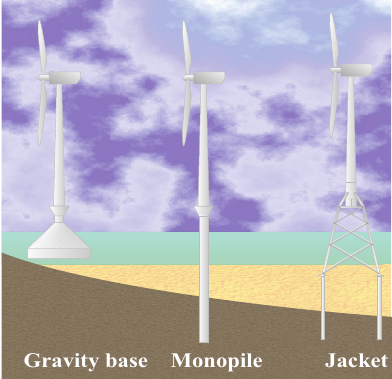
Figure 1. Generic foundation types for offshore